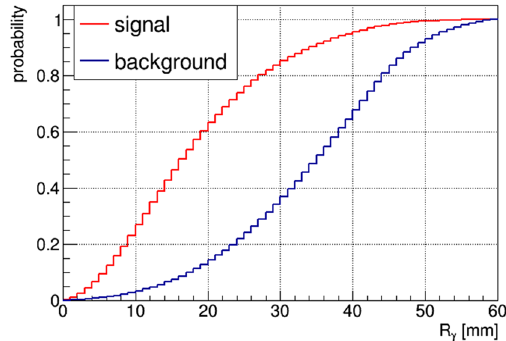
Fig. 7 The distribution of the probability that the distance, R γ , between the reconstructed photon impact point at the ZDC and the beam projection is smaller than a certain value. The red line the signal event sample, the blue line the background sample